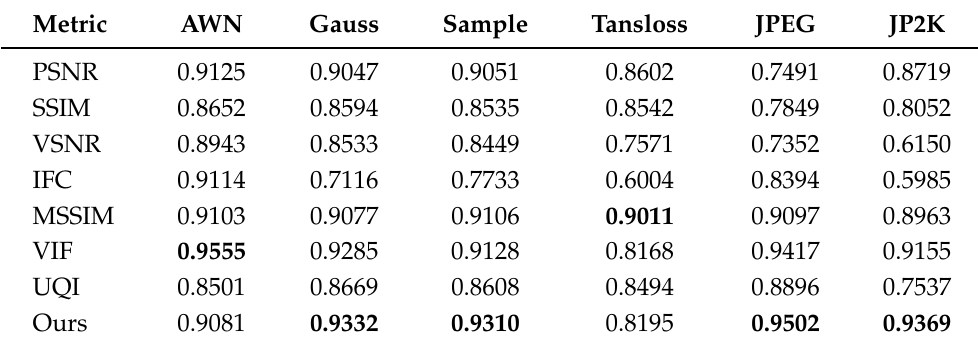
Table 3. Comparison of the proposed and the compared 2D image quality assessment (2D-IQA) metrics on individual distortion types in terms of Pearson linear correlation coefficient (PLCC). The best results are highlighted in bold.